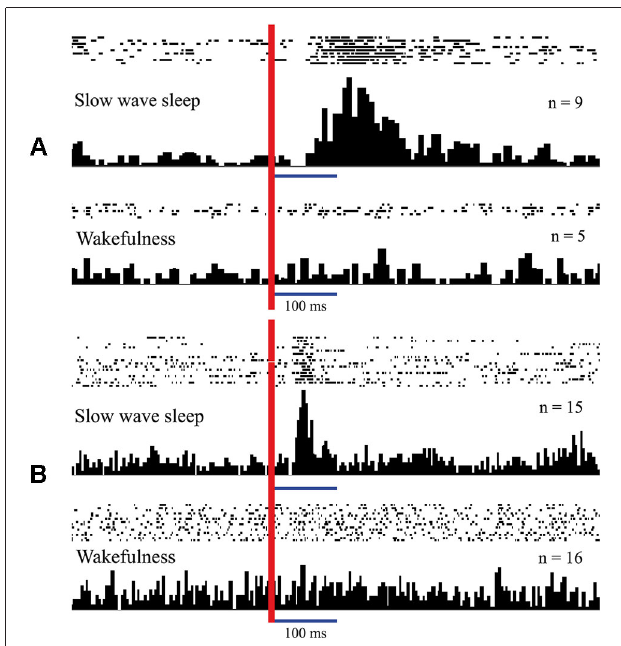
FIGURE 3 | Responses of neurons in the cat cortical visual area V1 (A) and somatosensory area 5 (B) to intraperitoneal electrical stimulation delivered in sleep and in wakefulness. Responses presented as rasters where every line corresponds to single stimulation trial. Dots represent single spikes. Below are averaged histograms. Vertical red line–moment of intraperitoneal stimulation. n—number of averaged trials. Technical details of the study in Pigarev (1994).